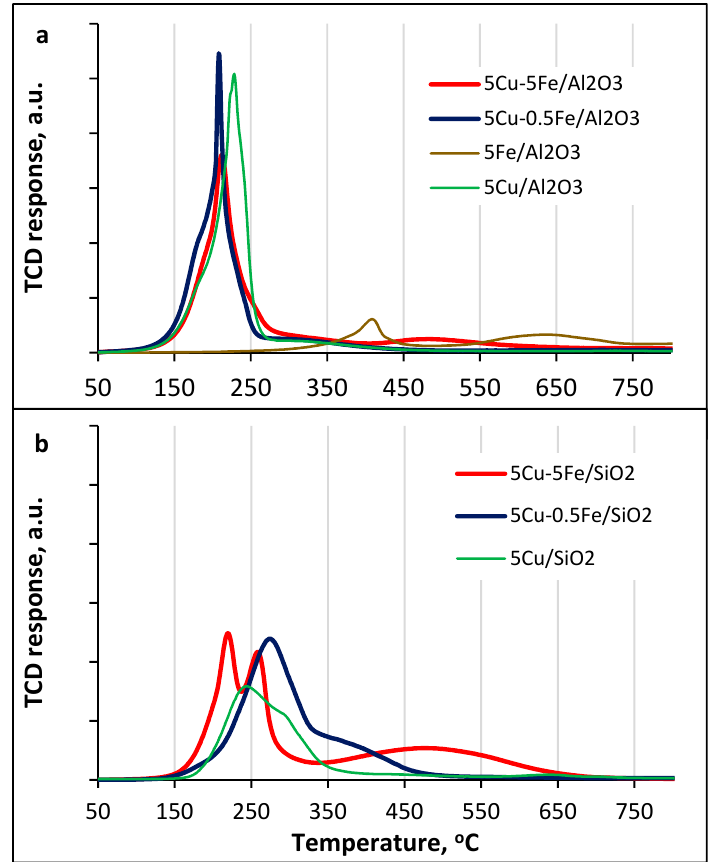
Figure 3. TPR curves of the calcined Cu-Fe samples on Al 2 O 3 ( a ) and SiO 2 ( b ). Table 1. H 2 uptake and reduction of peak temperatures of catalyst samples.